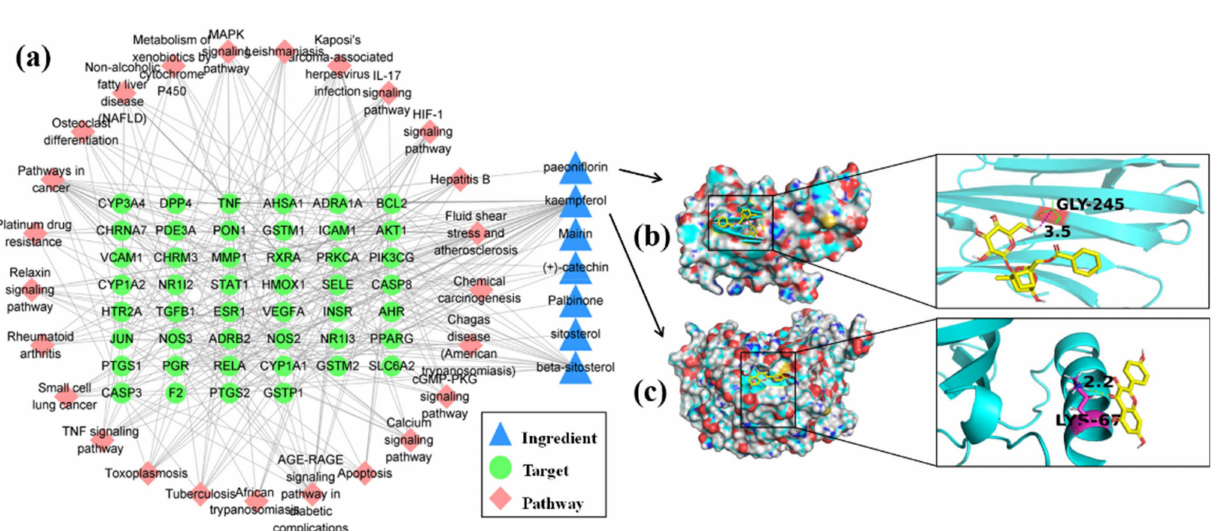
(Figure 7c), while for paeoniflorin and the target TNF (PDB ID: 1DU3), the docking binding energy of the residue CLY-245 was − 0.99 kcal/mol (Figure 7b). Palbinone, paeoniflorin, mairin, beta-sitosterol, sitosterol, kaempferol, and (+)-catechin can bind to the corresponding targets in different numbers, and they are sorted according to the degree unDir of binding from high to low as kaempferol, beta- sitosterol, (+)-catechin, paeoniflorin, mairin, sitosterol, and palbinone.